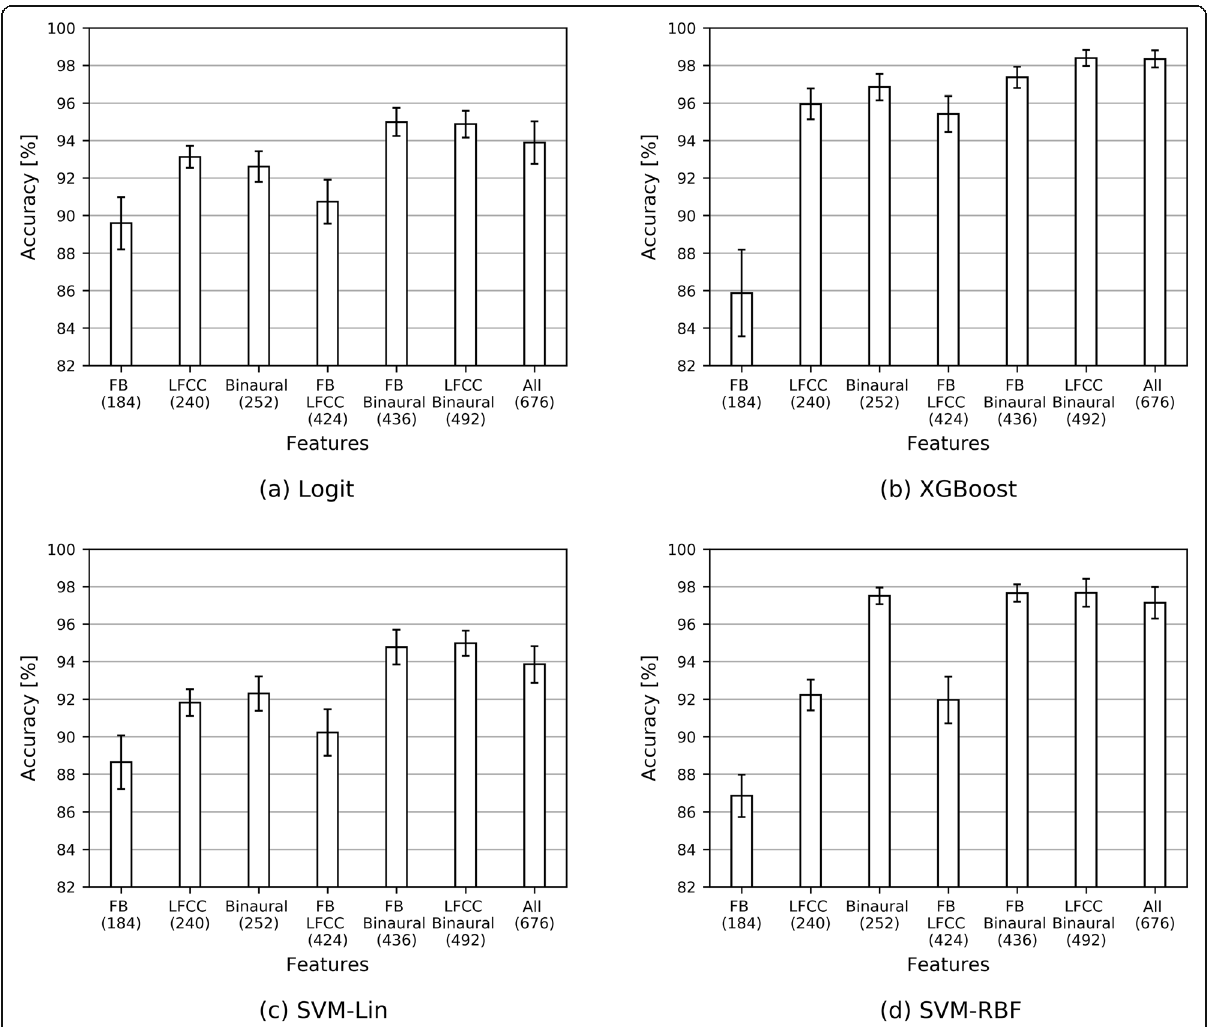
Fig. 8 Mean accuracy scores obtained for combination of features using a Logit, b XGBoost, c SVM-Lin, and d SVM-RBF. Numbers in brackets indicate the number of features. Error bars denote standard